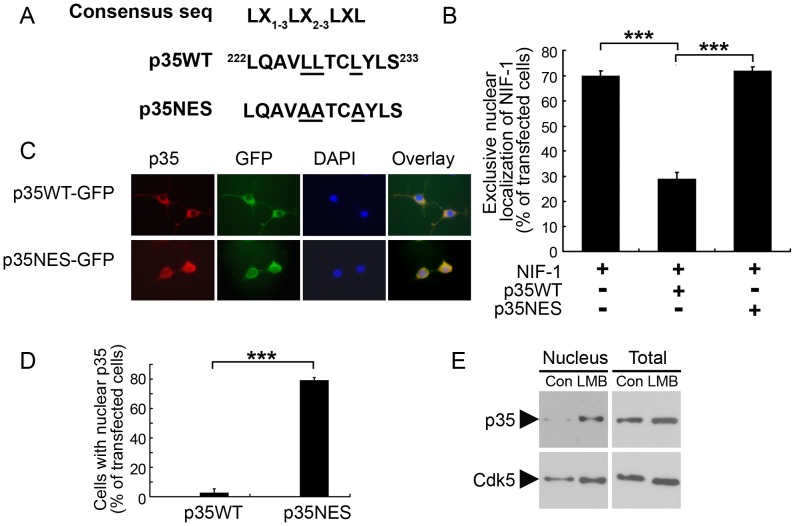
Dependence of p35 nuclear export on its NES.(A) Consensus sequence of the NES on p35. The functional NES comprises a core of closely spaced leucine residues or other hydrophobic amino acids. The critical hydrophobic residues in the putative NES of p35 are underlined. An NES mutant of p35, p35NES, was generated by mutating the 3 conserved hydrophobic residues (i.e., leucine 226, 227, and 230) to alanine. (B) The NES of p35 is required to mediate the nuclear export of NIF-1. COS-7 cells were co-transfected with HA-NIF-1 and p35WT or p35NES and subsequently stained with HA antibody. The results of the quantitative analysis represent the mean ± SEM of 3 replicates (***p <0.05, one-way ANOVA followed by the Student–Newman–Keuls test). (C) Mutating the NES of p35 increased the population of Neuro-2A cells containing nuclear p35. Neuro-2A cells were transfected with p35WT-GFP or p35NES-GFP and subsequently differentiated by RA. The cells were stained with p35 antibody. Representative fluorescent images depicting the localization of p35WT and p35NES (indicated by the p35 staining and GFP expression). (D) Quantitative analysis of cells with nuclear p35. Cells with nuclear p35 were counted if the GFP signal in the nucleus was>75% than that of the cytoplasm. Results represent the mean ± SEM of 3 replicates (***p <0.05, Student's t-test). (E) LMB treatment caused the accumulation of p35 in the nucleus of cortical neurons. Cultured cortical neurons were treated with LMB for 1 h, and subcellular fractionation was performed. Western blot analysis of p35 and Cdk5. Total: protein extracted from the same batch of neurons using RIPA.